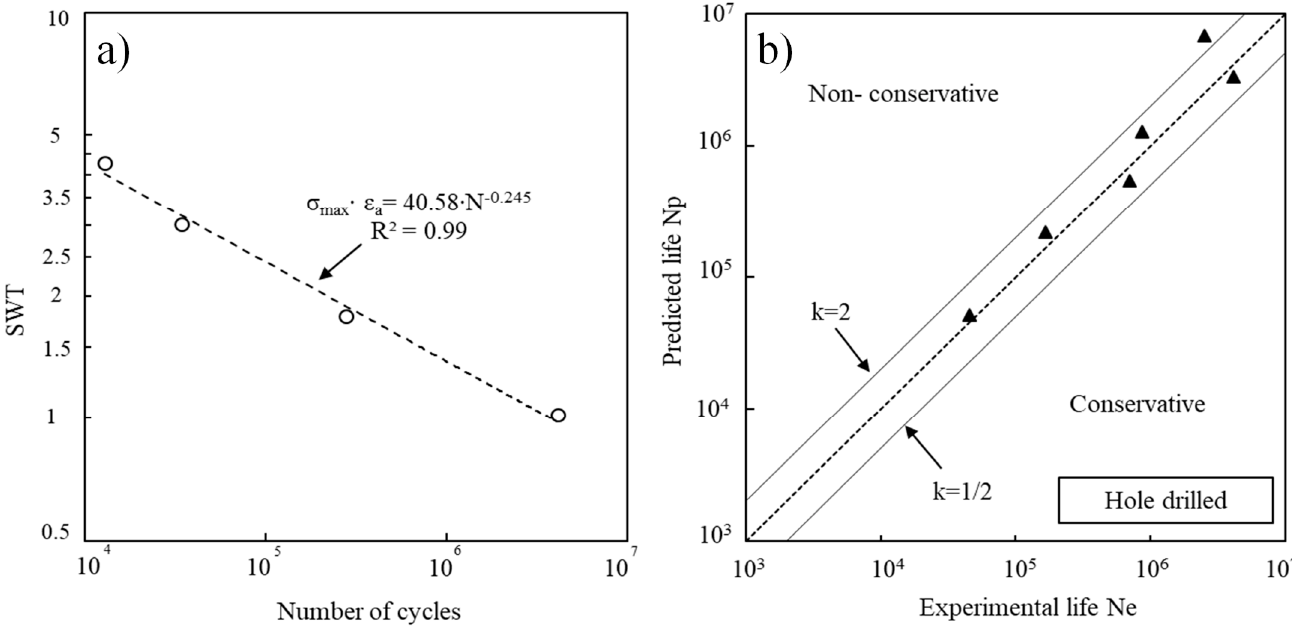
Figure 8. ( a ) SWT parameter vs. number of cycles to failure for the solid specimens; ( b ) Fatigue life predictions vs. experimental fatigue lives for the hole drilled series.